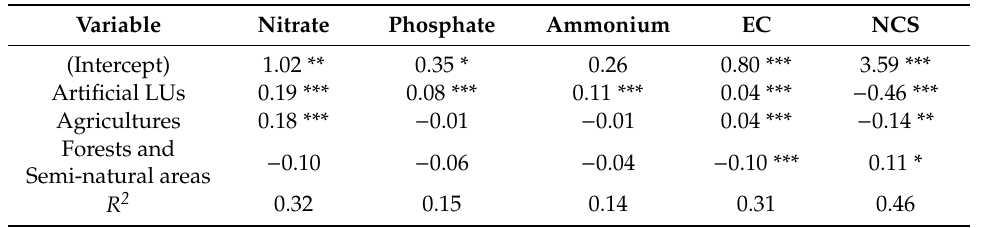
Table 3. Linear model fitting results for nitrate, phosphate, ammonium, and EC to Agriculture, Artificial and Forest and semi-natural land uses.